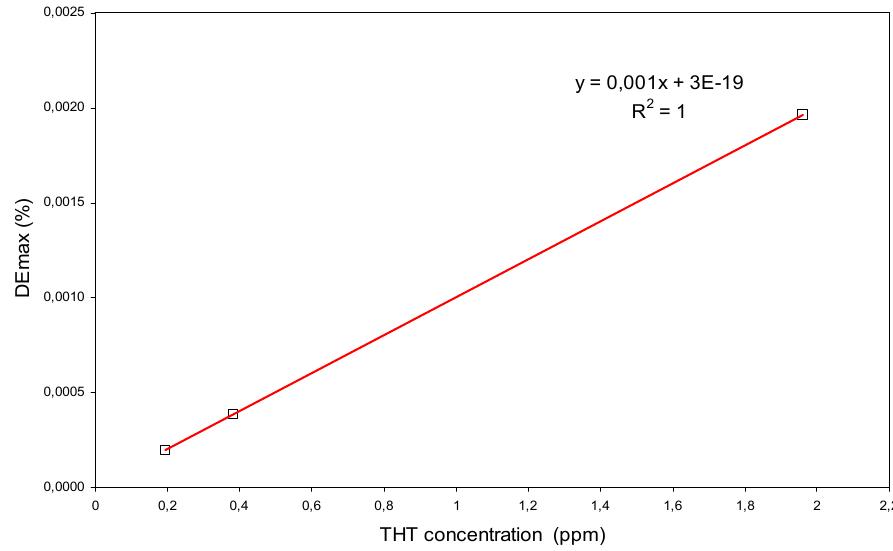
Figure 13. DEmax versus concentration of THT.